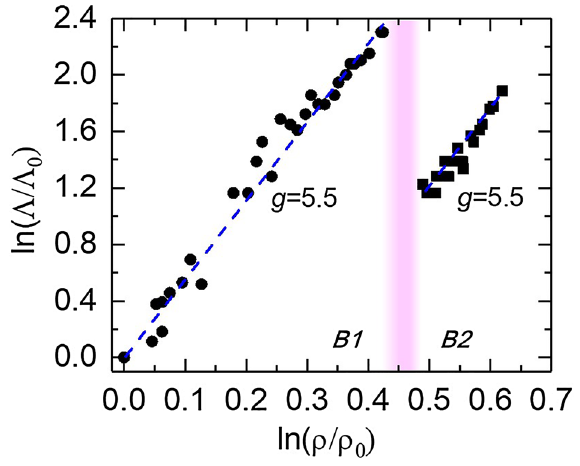
Figure 3. Logarithmic normalized thermal conductivity as a function of logarithmic normalized density. The blue dashed lines are linear fits to the data with a slope ( g ) of 5.5 for both B1 and B2 phase. The pink shaded region labels the B1–B2 transition.